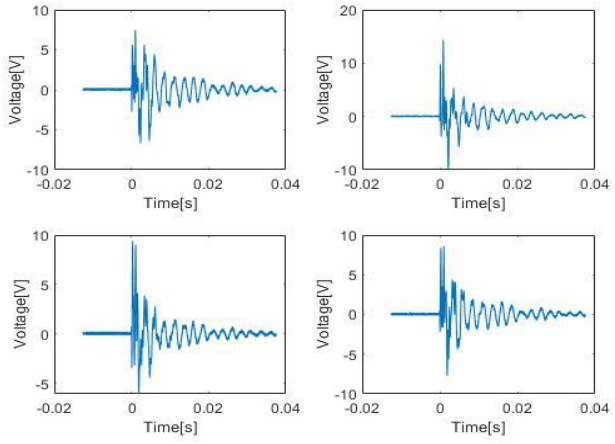
Figure 7. HI’s from four sensors.